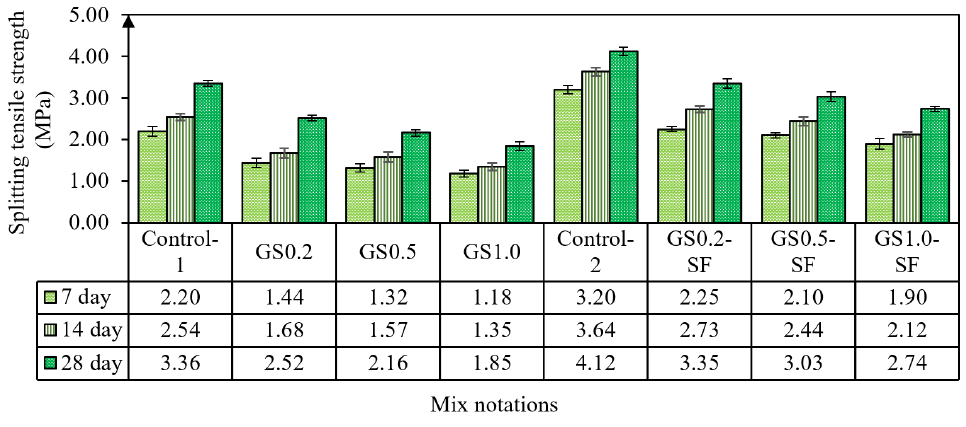
Fig. 6. Splitting tensile strength of CRT